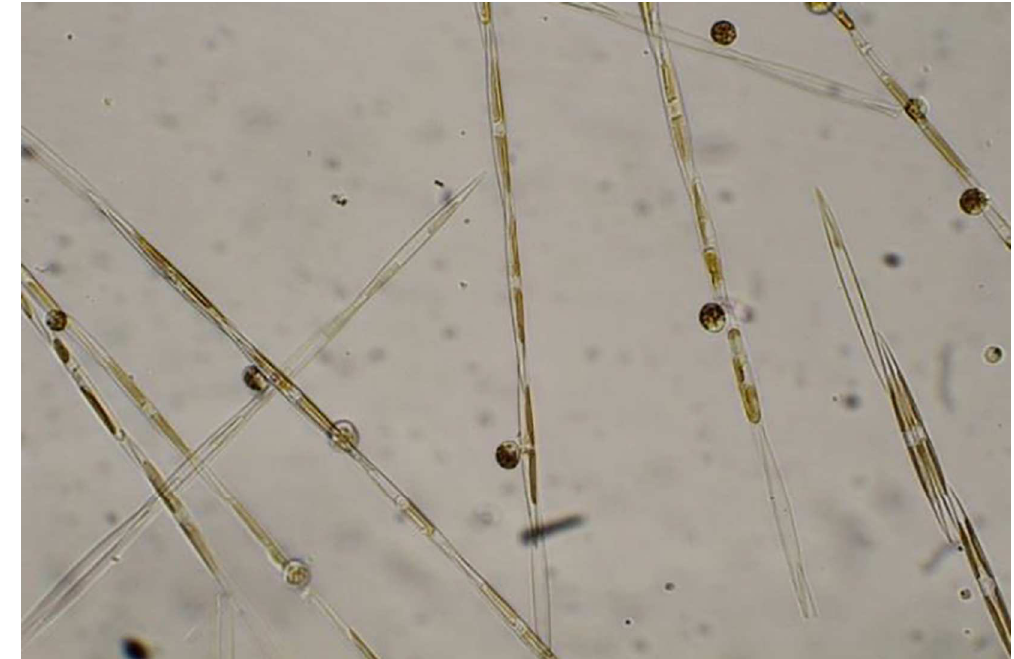
Fig 4. An image of the large celled